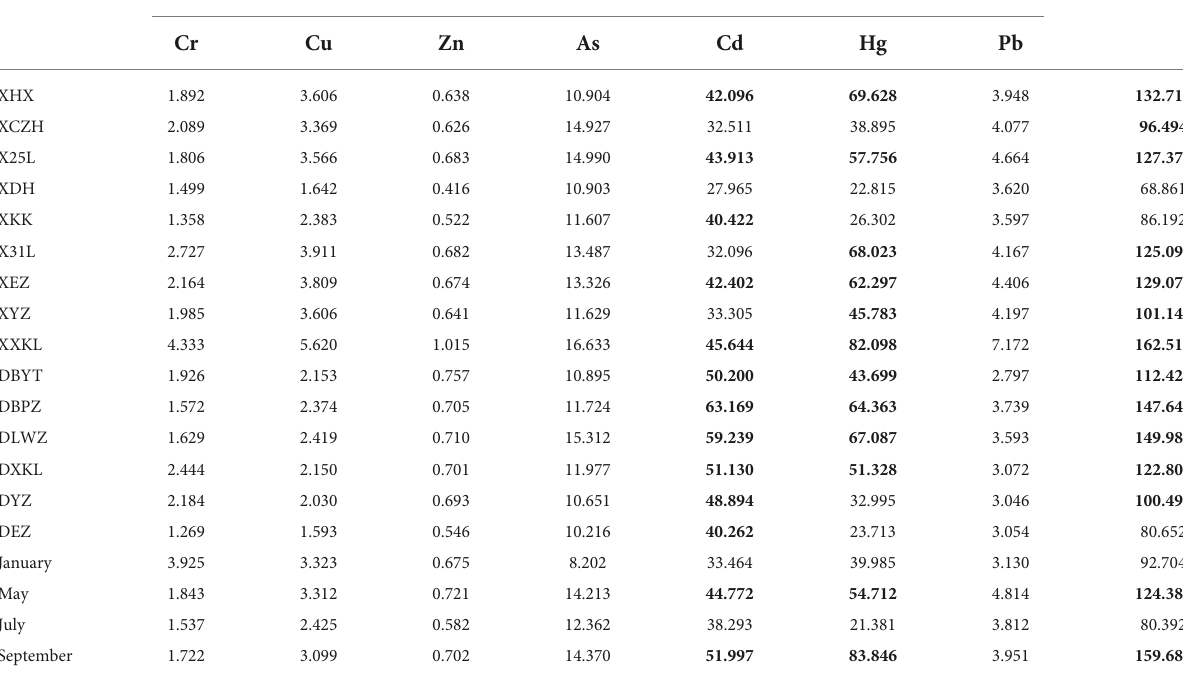
TABLE 5 Potential ecological risk index (PERI) of heavy metals in sediments at different sampling months and